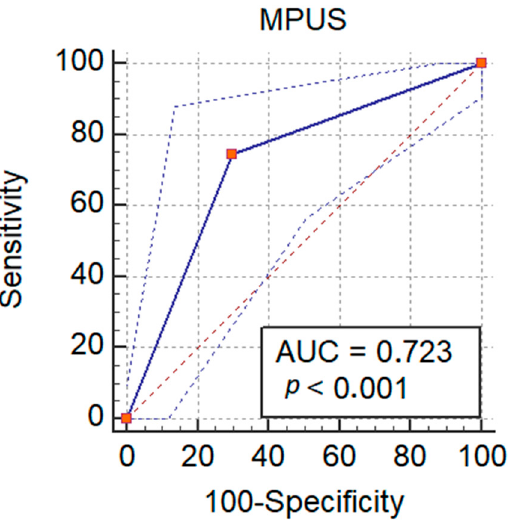
Figure 8. Performance of MPUS in detecting malignant liver lesions.